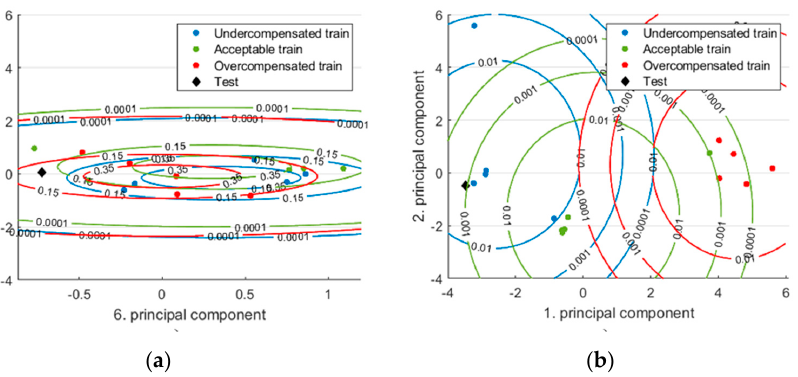
Figure 13. Training data and test data (from the undercompensated class) with distributions pre- sented in two different dimension planes: ( a ) in dimensions created by the sixth and the seventh principal component; ( b ) in dimensions created by the first and the second principal component. Note that we used five training samples per class.